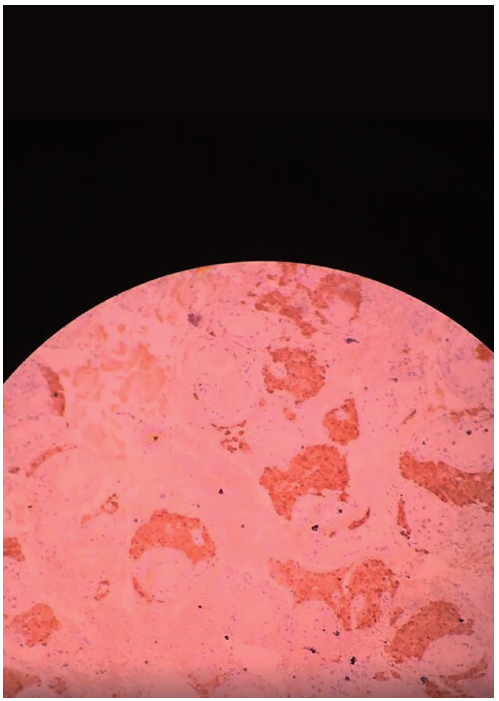
Figure 3 - Rete Testis and Seminiferous tubules (4x).